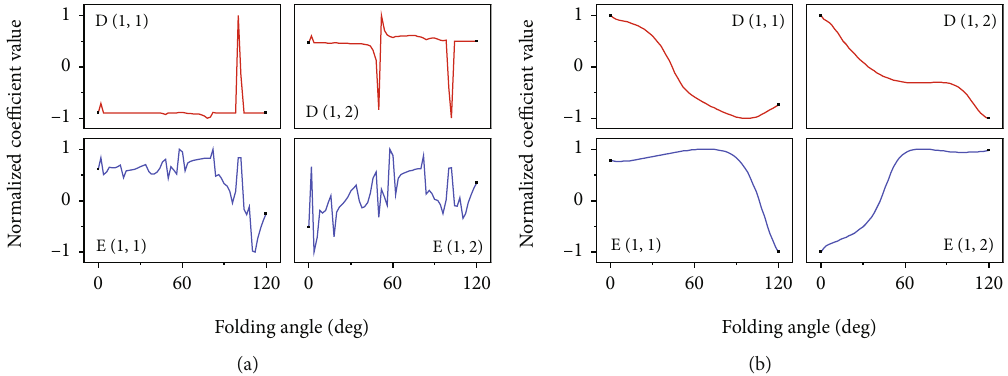
Figure 8: Variations of coe ffi cient matrices D and E in the RFA representation. (a) Normal RFA. (b) Coherent